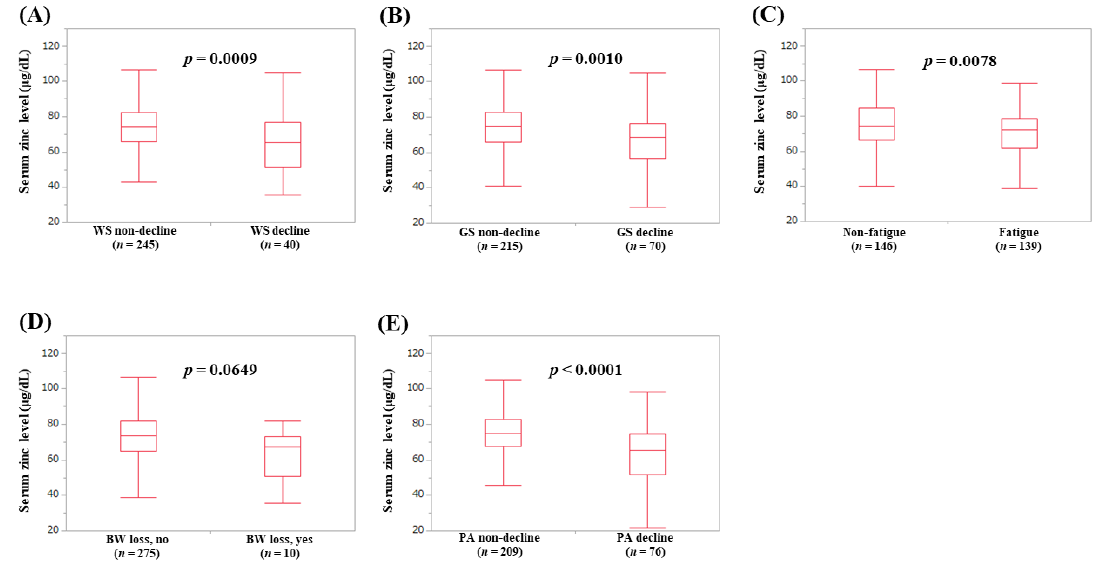
Figure 3. Serum Zn level according to each frailty phenotype: ( A ) walking speed, ( B ) grip strength, ( C ) fatigue, ( D ) body weight loss, ( E ) physical activity.